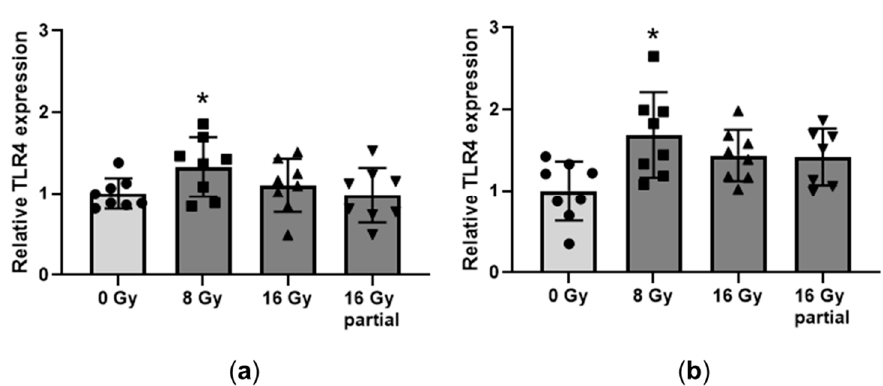
Figure 2. Left ventricular protein levels of TLR4. Western blotting was performed on specimens of the left ventricle in the top part of the heart ( a ) and the bottom part of the heart ( b ). Male and female data are combined, n = 7–8 animals per group. * p < 0.05 compared to 0 Gy.